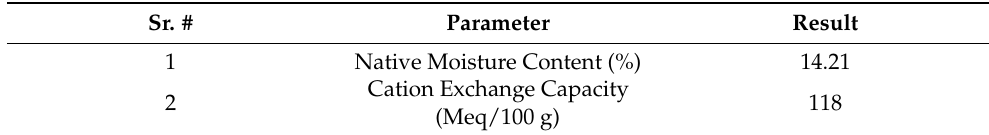
Table 1. Results of parameters for clay